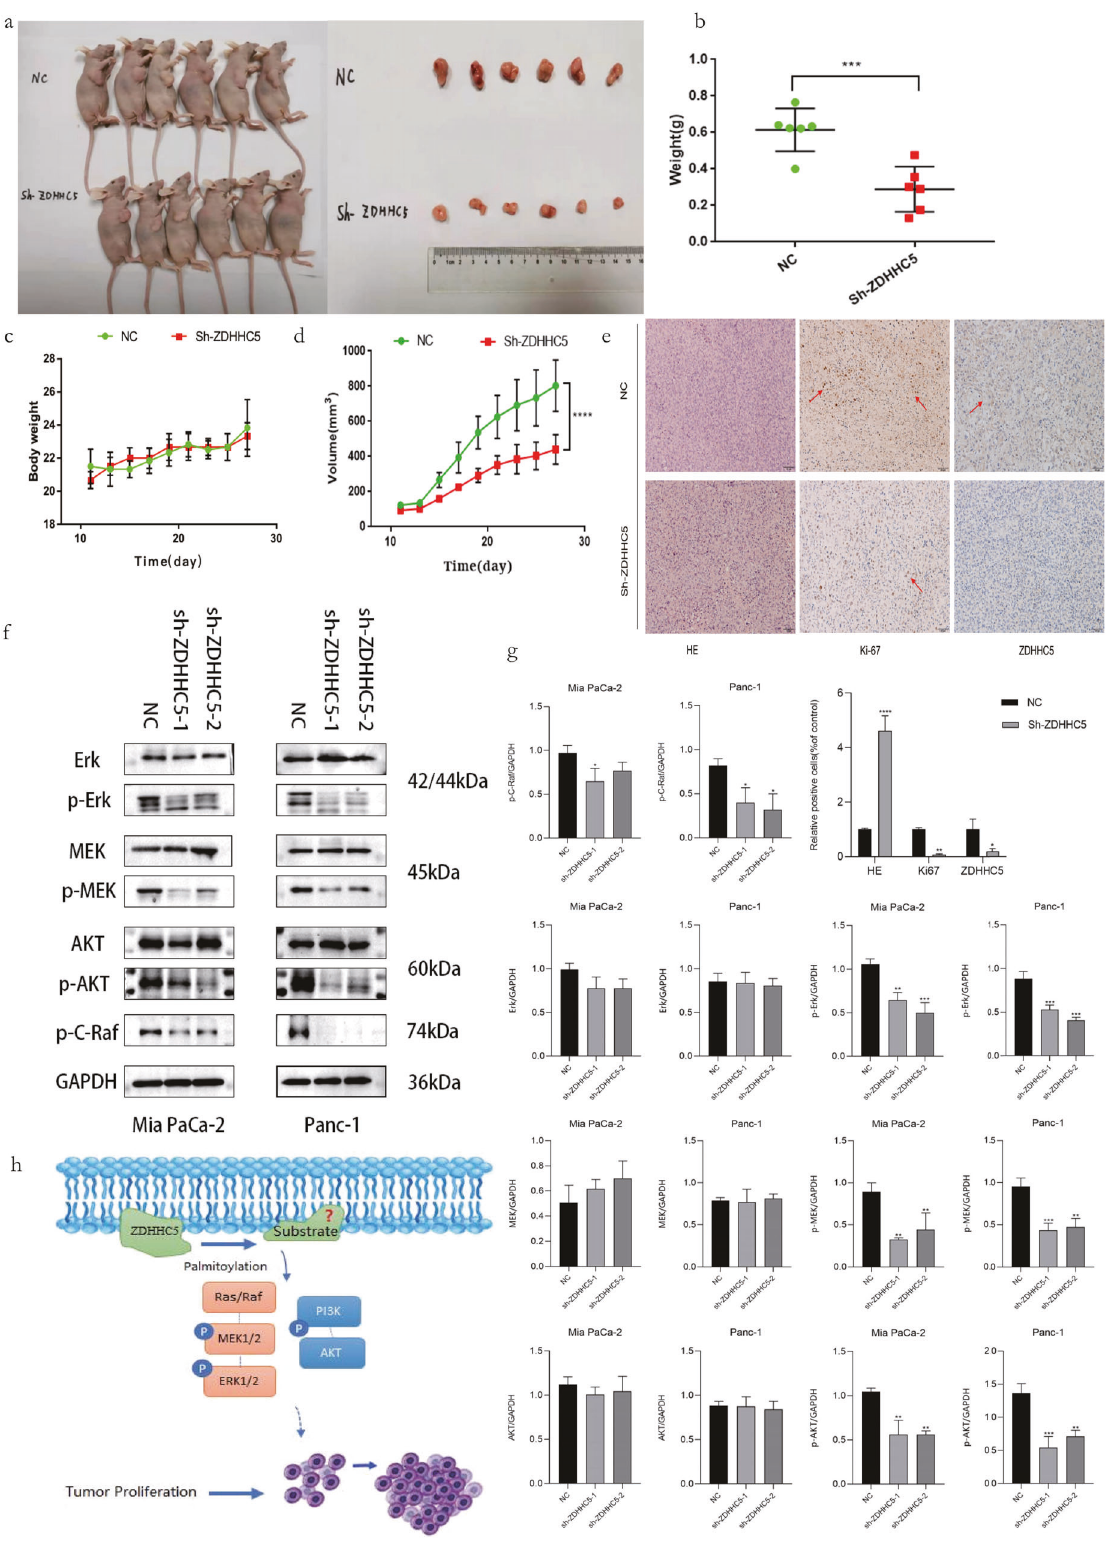
Evaluation of Lomitapide in vivo We choose Mia PaCa-2 cell line for xenograft experiment in BALB/c Female nude mice. Mice in the treatment groups were intraperitoneally injected with Lomitapide at dosages